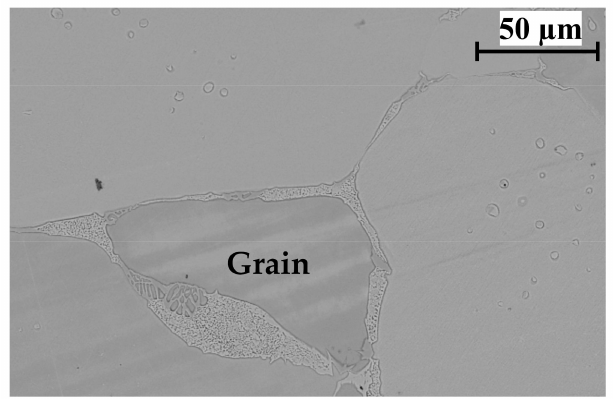
Figure 10. SEM (scanning electron microscope) image of Z1 in the sample Ni-Age-Wasp etched. Etchant: 10 g CuCl, 40 mL HCl, 60 mL ethanol.